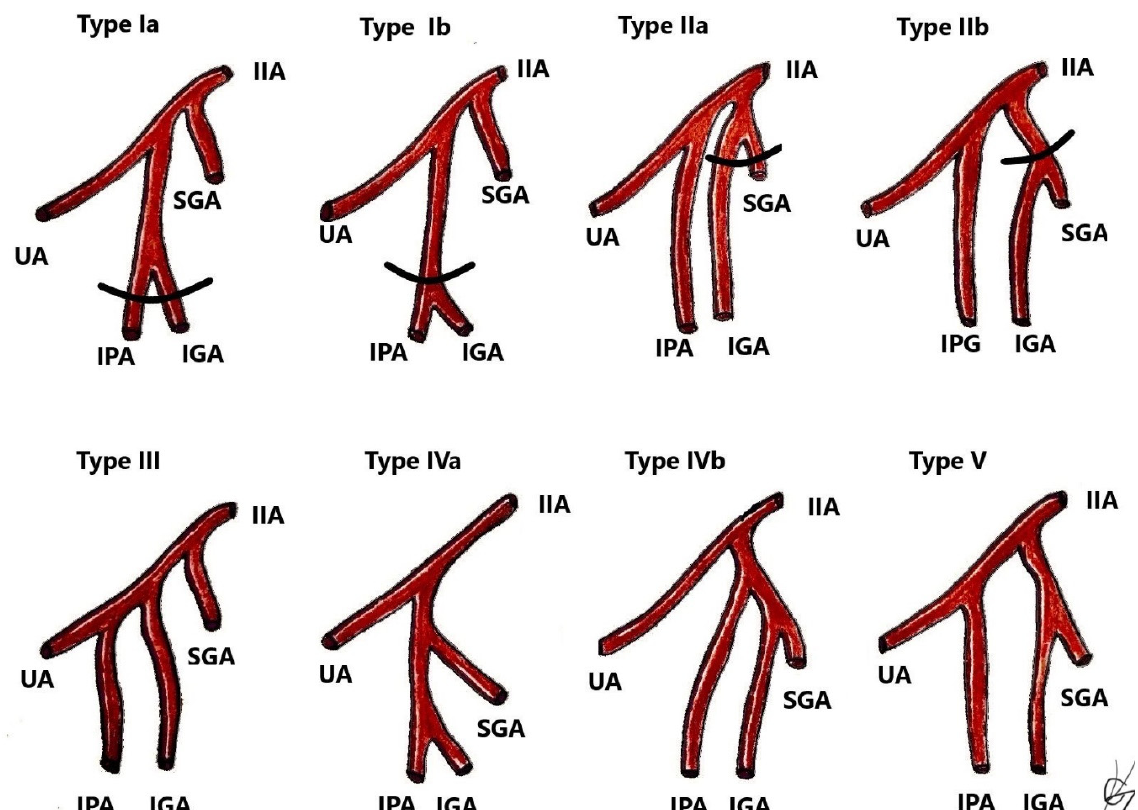
Figure 10. Classification of IIA variations. Adopted from Adachi [58]. Type I—The superior gluteal artery (SGA) arises separately from internal iliac artery, while the inferior gluteal (IGA) and internal pudendal vessel (IPA) share a common trunk. Type Ia—the bifurcation of IGA and IPA occurs within the pelvis. Type Ib—the bifurcation occurs below the pelvis. Type II—The internal pudendal artery arises separately from the IIA, while the superior gluteal artery shares a trunk with the inferior gluteal artery. Type IIa—the bifurcation of SGA and IGA occurs within the pelvis. Type IIb—the bifurcation occurs below the pelvis. Type III—SGA, IGA, and IPA arise separately from the internal iliac artery, and the internal pudendal artery is the last branch. Type IV—SGA, IGA, and IPA share a common trunk. Type IVA—the SGA is the first vessel from the common trunk, before bifurcating into the other two branches—SGA and IGA. Type IVB—the IPA is the first from the common trunk, which then divides into SGA and IGA. Type V—The IGA has a separate origin from the IIA, while the SGA and IGA share a common trunk.